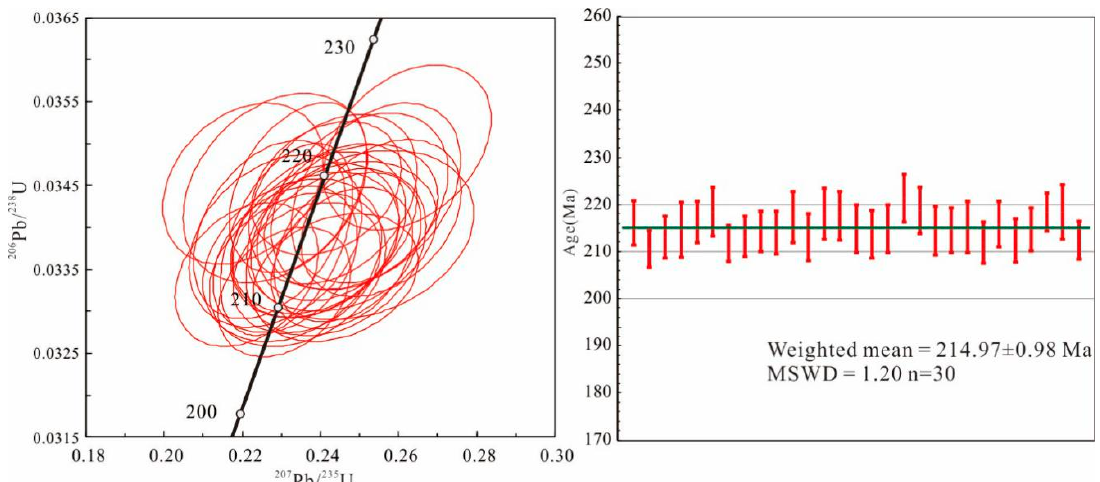
Figure 4. Zircon U-Pb Concordia and 206 Pb/ 238 Pb weighted mean age diagrams for the Changdagou granodiorite porphyry.